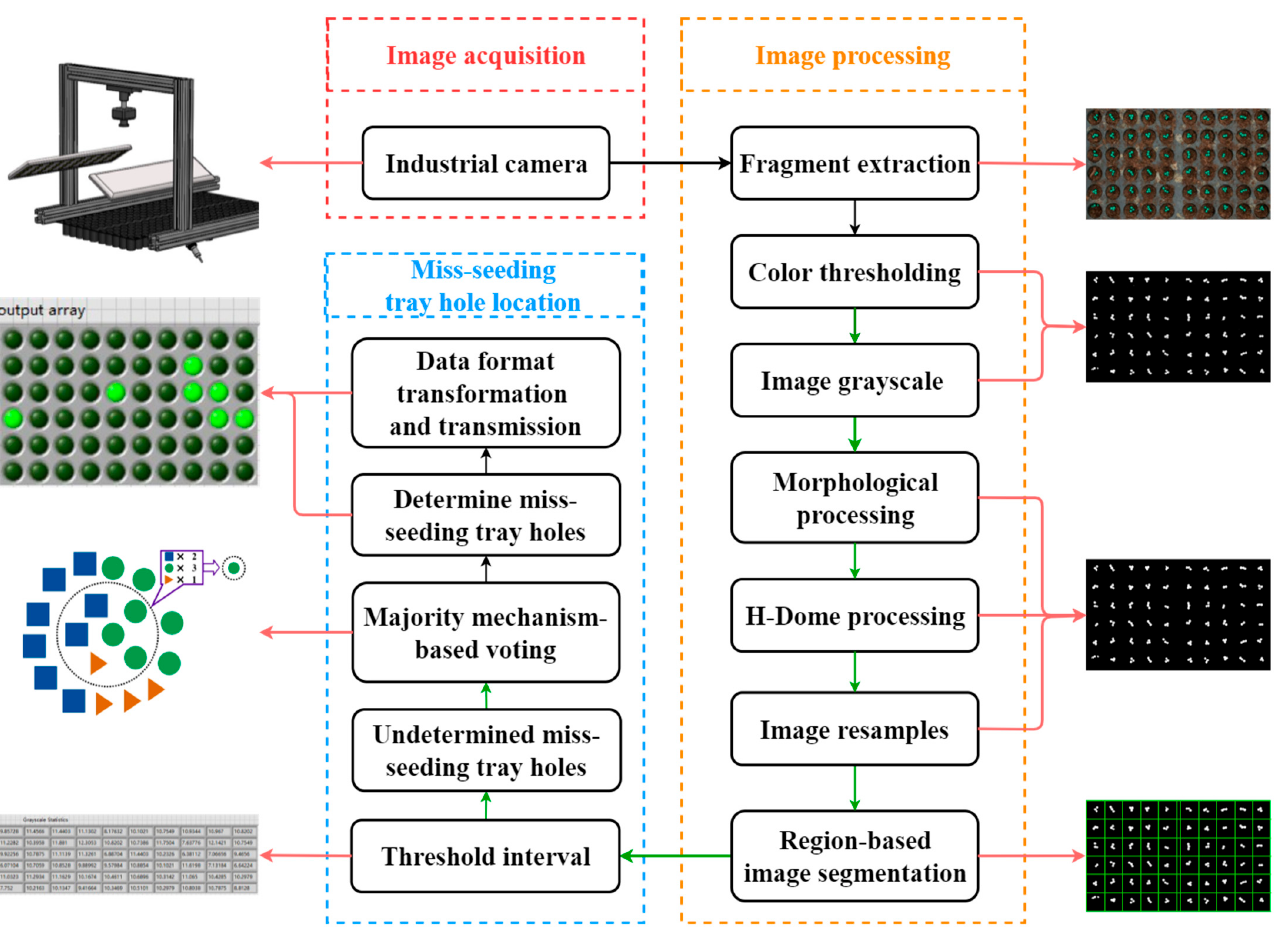
Figure 10. Image processing flowchart. Note: The green arrows in Figure 10 represent the simultaneous processing of the same image in three color spaces. The bright green circle in the output array represents the position of the detected miss-seeding holes.